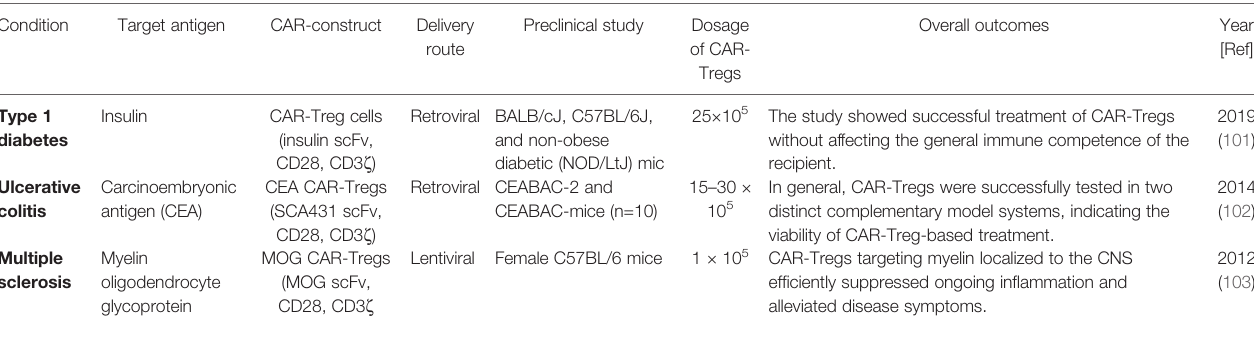
TABLE 1 | CAR-Treg-based therapy in preclinical models of autoimmune diseases.